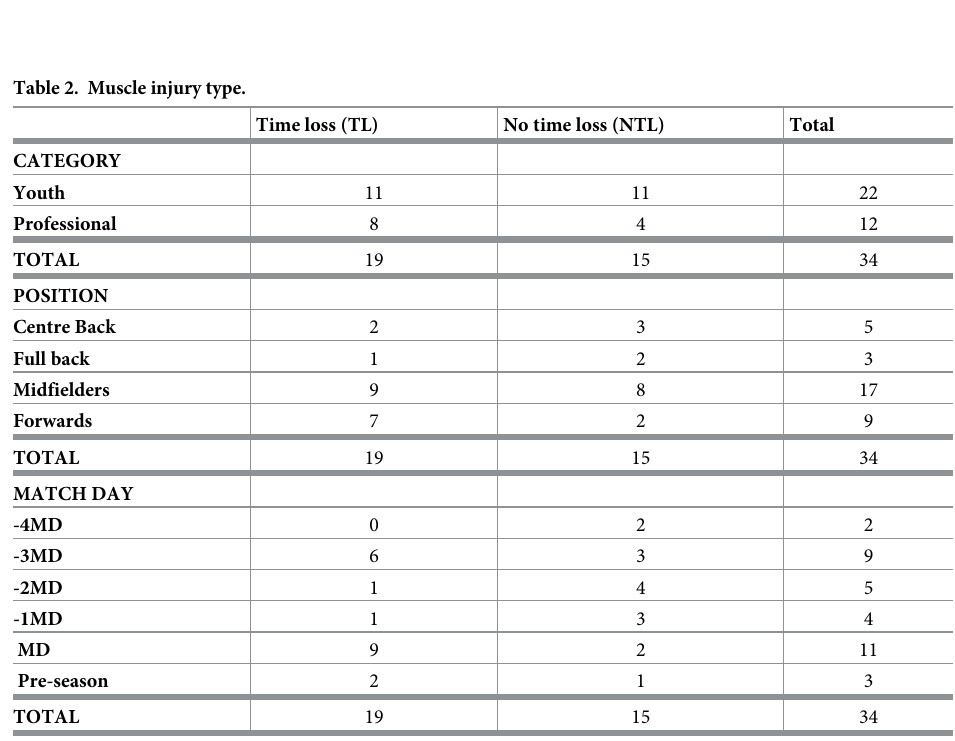
Fig 2. Boxplots without outliers of GPS load metrics HMLD, HSR, PL, and TD per minute for each category, position, and training/match day. n p = Number of players; n s = Number of sessions.